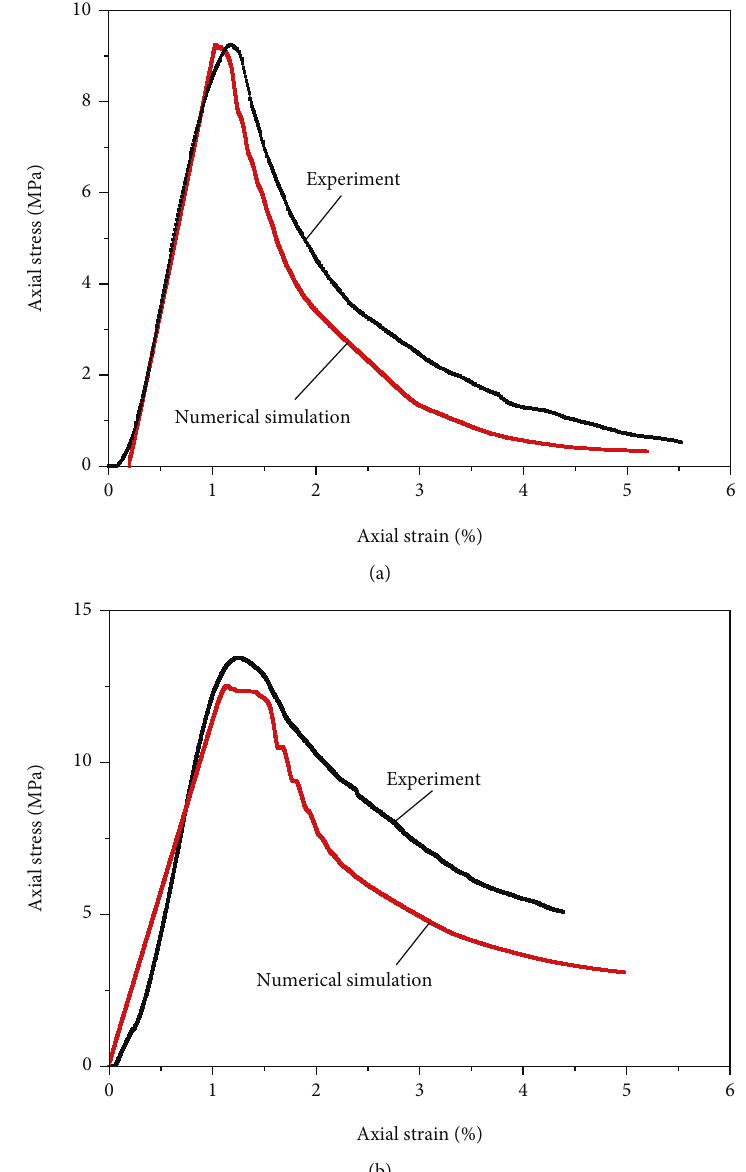
Figure 6: Axial stress vs. axial strain curve comparison between experiment and numerical simulation results of rock mass specimen with (a) no bolt and (b) one bolt reinforced,